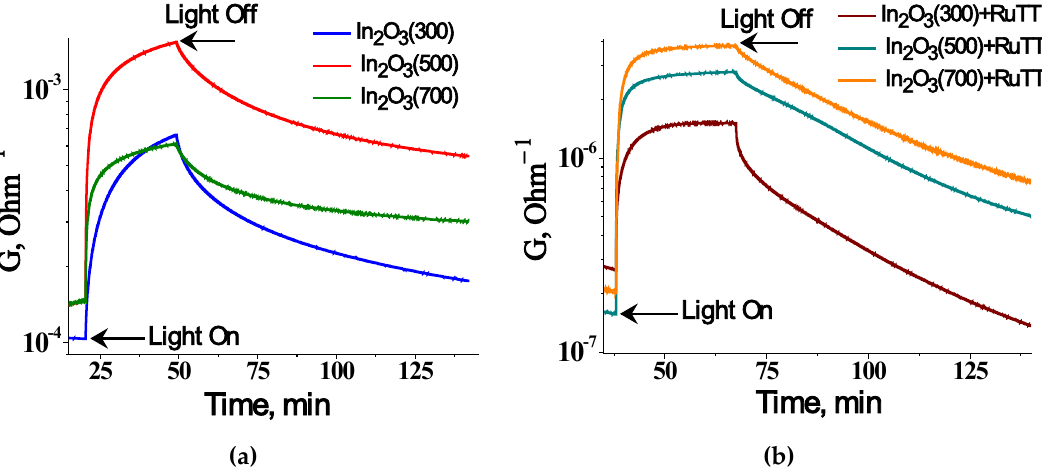
Figure 6. Change in the conductivity of pure In 2 O 3 with different grain sizes ( a ) and hybrid materials ( b ) under dark and irradiation conditions.